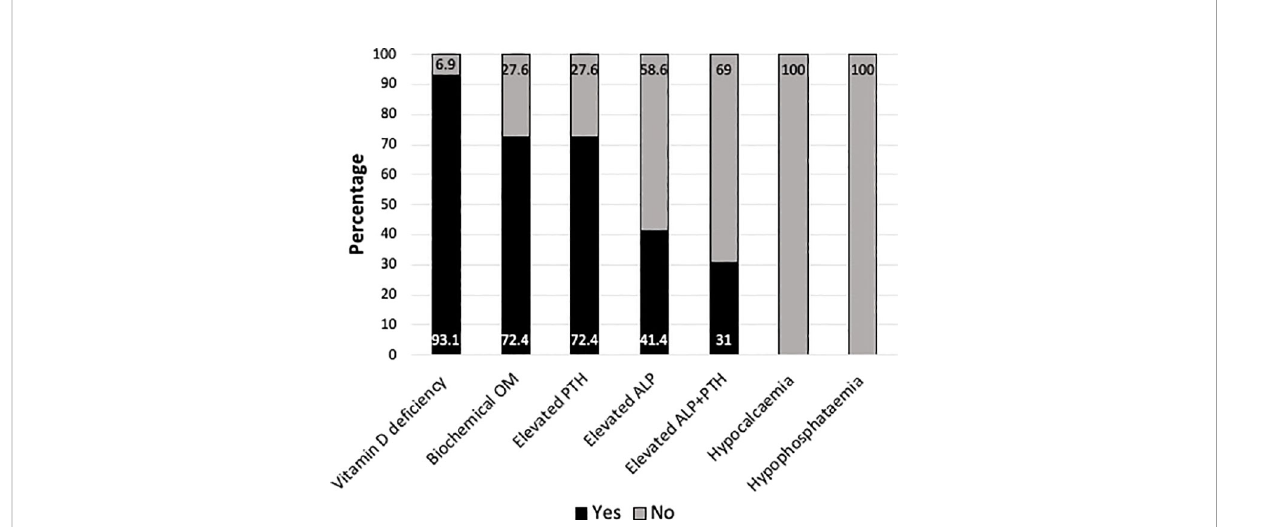
FIGURE 2 Bar chart representing the proportion of mothers with vitamin D de fi ciency (25hydroxyvitamin D <30 nmol/L) (n=27/29), biochemical osteomalacia (OM)* (n=21/27), elevated parathormone (PTH)(n=21/29) or alkaline phosphatase (ALP)(n=12/29) or both (n=9/29), hypocalcaemia (n=0/29) and hypophosphataemia (n=0/29). *Biochemical OM was de fi ned as 25OHD <30 nmol/L + elevated ALP and/or